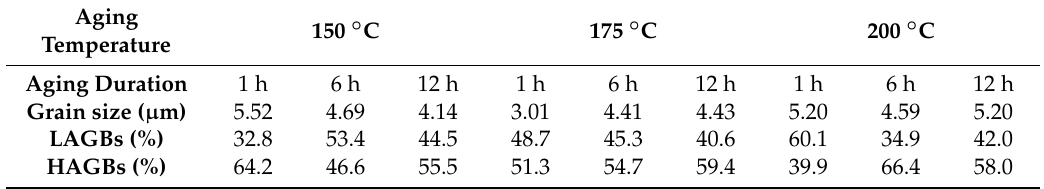
Table 2. Grain size and grain boundary statistics for FSP samples subjected to artificial aging.